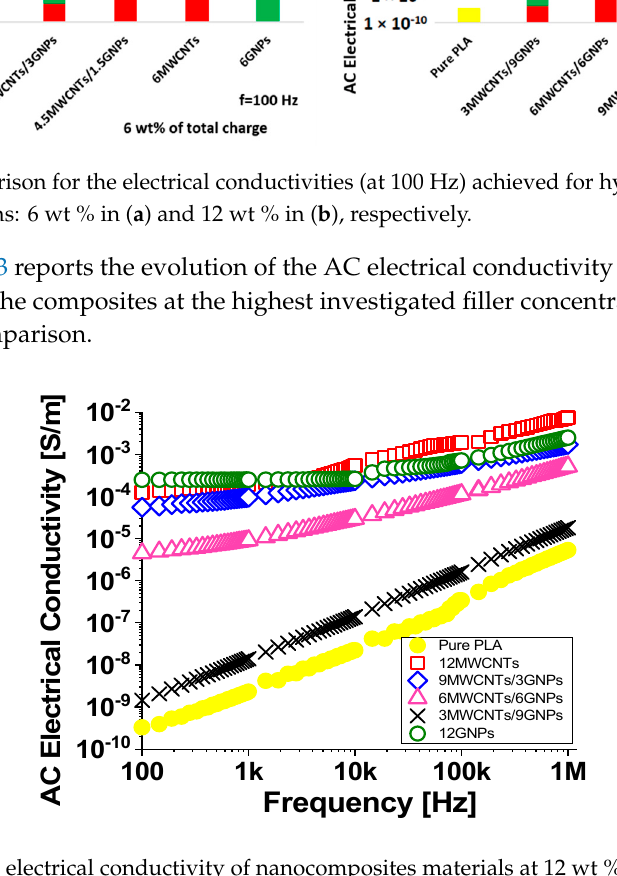
Figure 13. AC electrical conductivity of nanocomposites materials at 12 wt % of total charge.